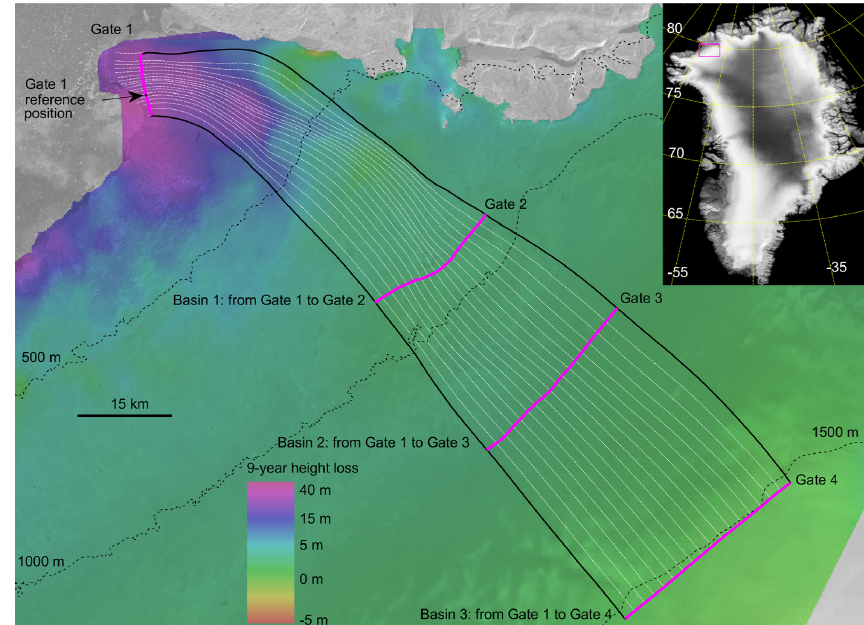
Figure 1. The positions of the three basins are defined by the four gates and the outer black flow lines. The white lines are also flow lines derived from the x and y components of the 2018–2019 200m MEaSUREs velocity product. The 9-year height loss is illustrated by the colour overlay on the Sentinel SAR image from 27 July 2019. The position of the test area is shown in the insert image by the magenta box in the NW corner of